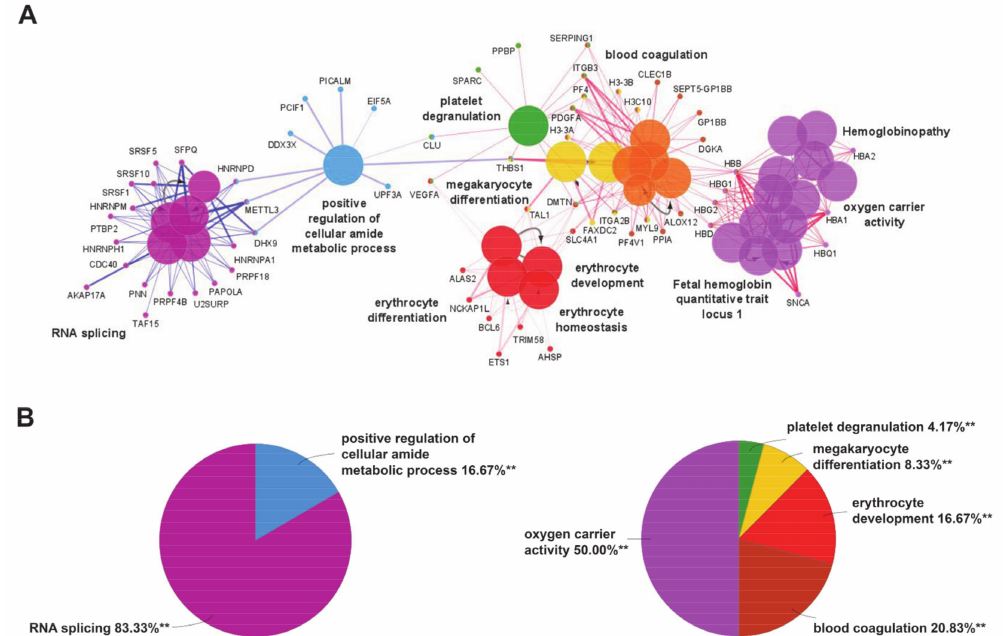
Figure 1. ( A ) Enrichment by gene ontology terms was performed using the ClueGO/CluePedia plugin (v 1.5.7) in Cytoscape software (v 2.5.7). The connectivity of the GO terms network is illustrated by functional nodes and edges that are shared between the differentially expressed genes (downregulated genes in blue and upregulated genes in red) with a kappa score threshold of 0.4. The enrichment shows only highly significant GO terms ( p -value ≤ 0.001). The node size shows the term significance. The node color indicates the specific functional annotation of ontologies in which the genes are involved. Functionally related groups partially overlap. The most significant terms of a group are highlighted in the network in bold fonts. The names of the differentially expressed genes involved in each group are displayed in uppercase font. ( B ) Pie charts of the enriched biological functions illustrating the %terms/group based on gene ontology classification of the differentially expressed genes (downregulated on the left and upregulated on the right) (** p -value ≤